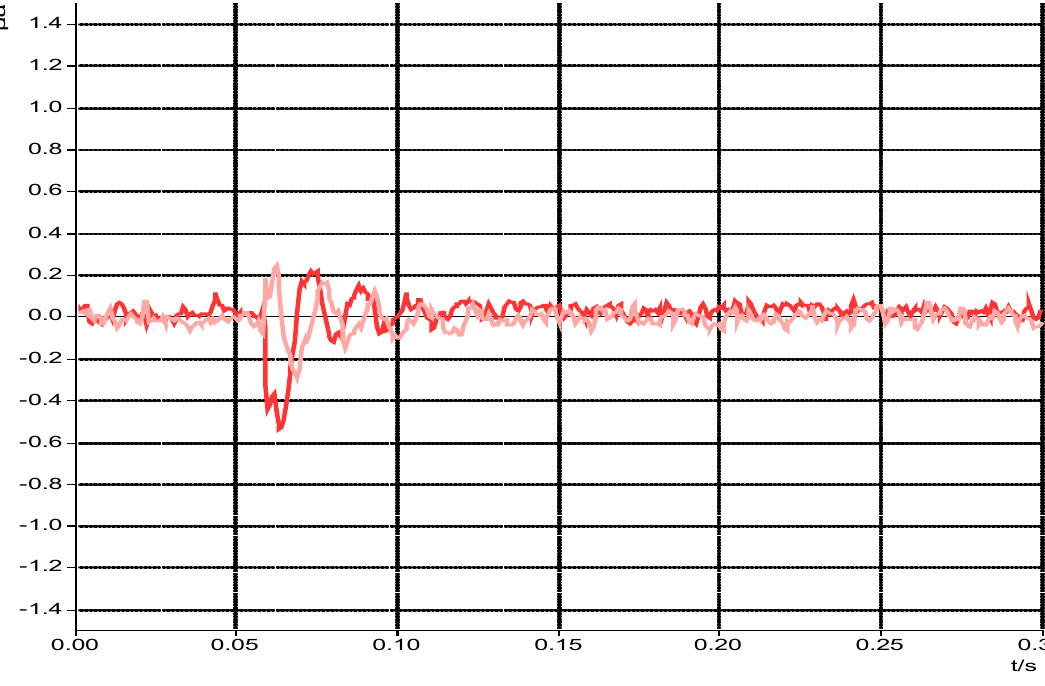
Figure 26. Current for (cid:1856)(cid:1869) axes in a negative sequence.